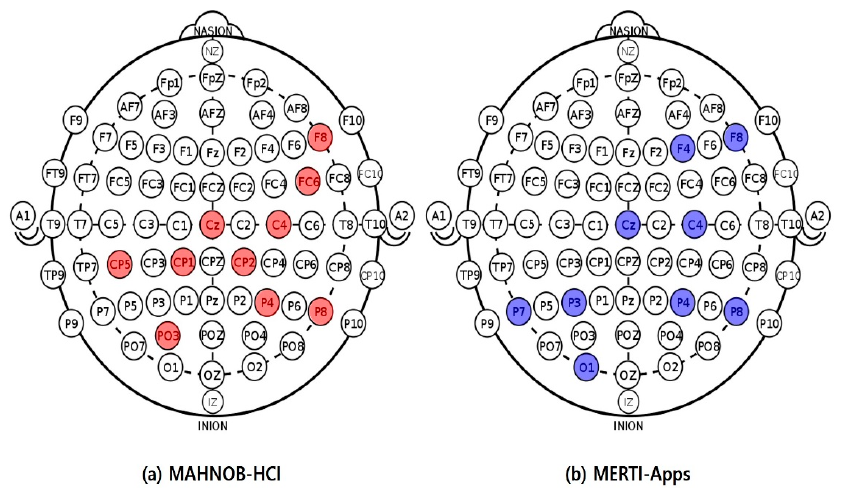
Figure 6. E ff ective channel comparison between ( a ) MAHNOB and ( b ) MERTI-Apps datasets. Figure 6. Effective channel comparison between ( a ) MAHNOB and ( b ) MERTI-Apps datasets.